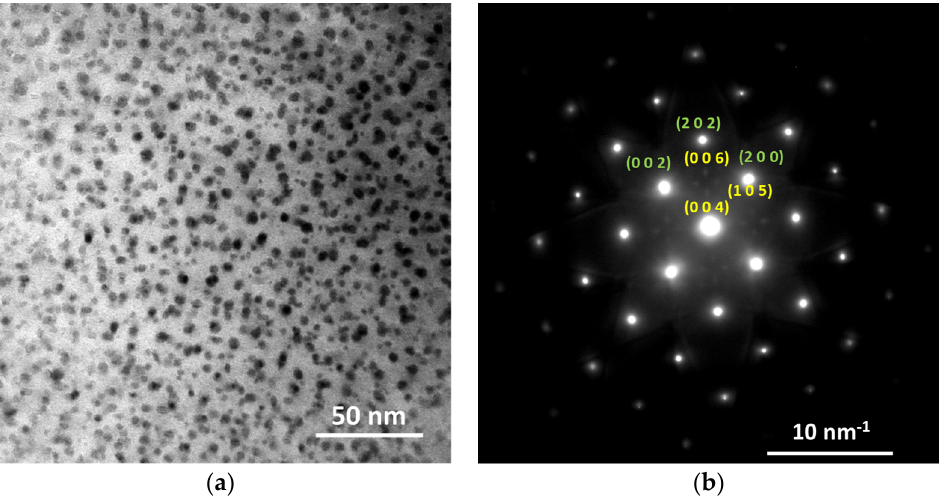
Figure 5. TEM images showing the typical microstructure of T6–b sample: ( a ) BF image; ( b ) SAED pa tt